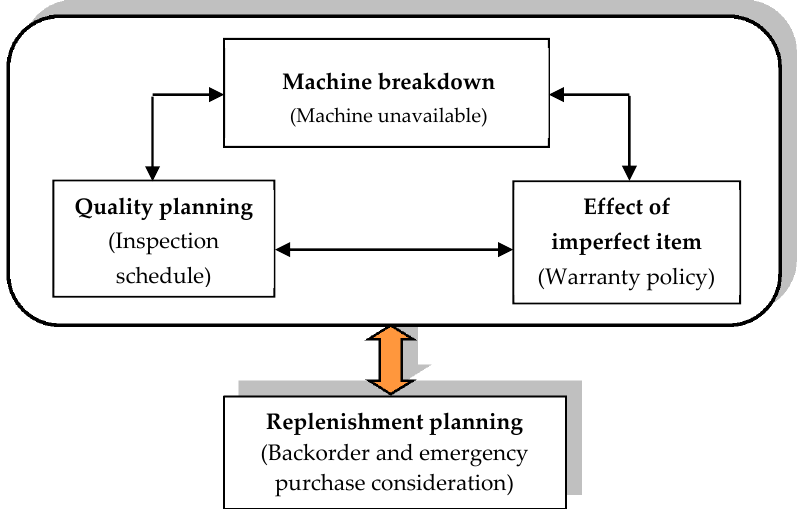
Figure 1. The replenishment planning of economic production quantity (EPQ ) deteriorating model.